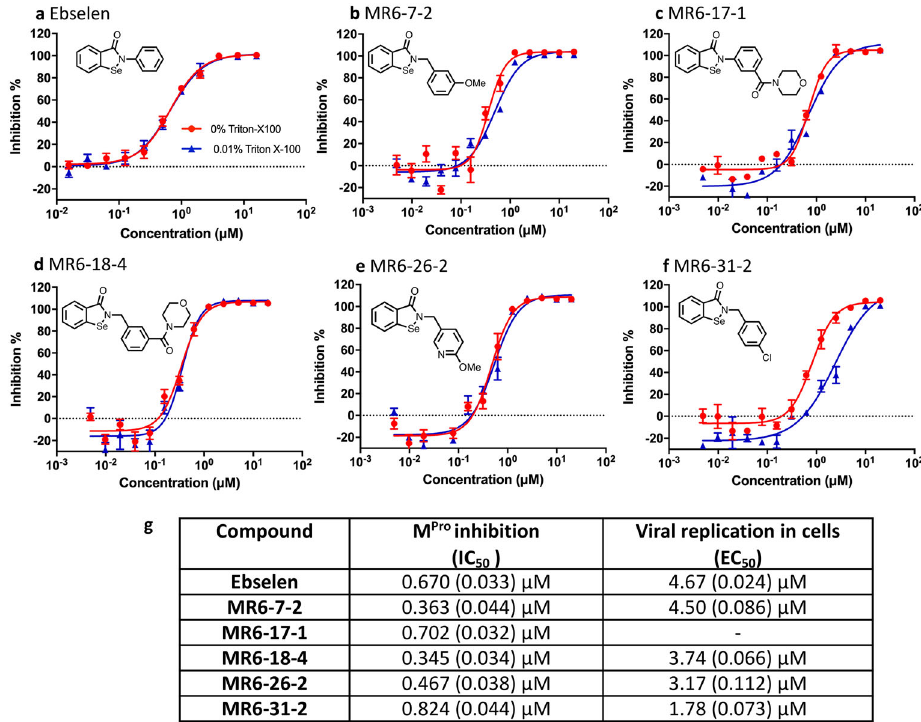
Fig. 1 Chemical structures, in vitro M pro inhibition and cell-based antiviral assays of ebselen and fi ve derivatives. In vitro M pro inhibitory curves of a ebselen, b MR6-7-2, c MR6-17-1, d MR6-18-4, e MR6-26-2 and f MR6-31-2. Inhibition percentage plots are means of n = 3 measurements obtained over three independent experiments and error bars representing the standard error of the mean. g IC 50 s of M pro inhibition and EC 50 s of viral replication in Vero E6 cells. IC 50 s and EC 50 s are means (standard error of log(concentration)).